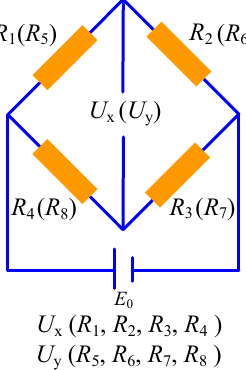
Figure 2. The Wheatstone